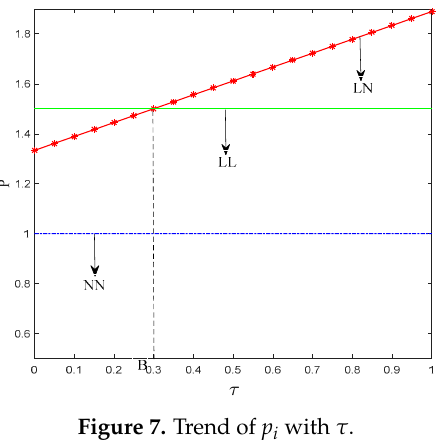
Figure 7. Trend of p i with τ .